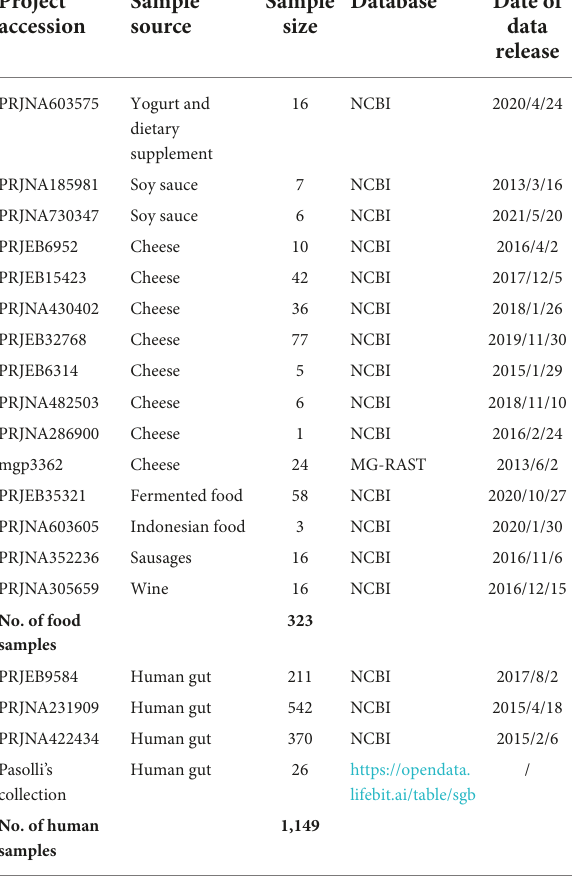
TABLE 1 Summary of the collected food and human gut metagenomic